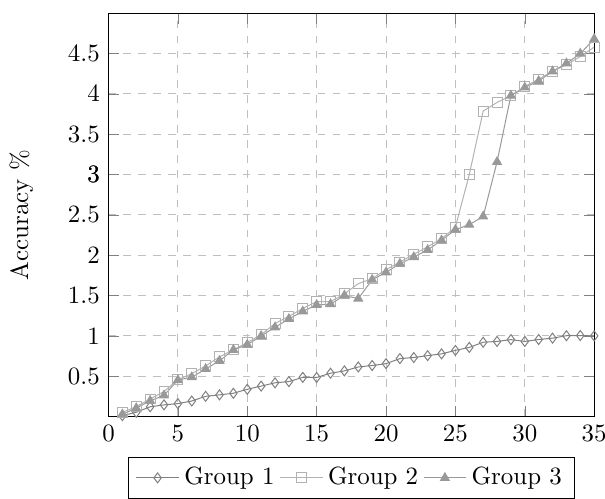
Figure 15. Training time for the GID when using an increasing number of hidden-layer neurons.